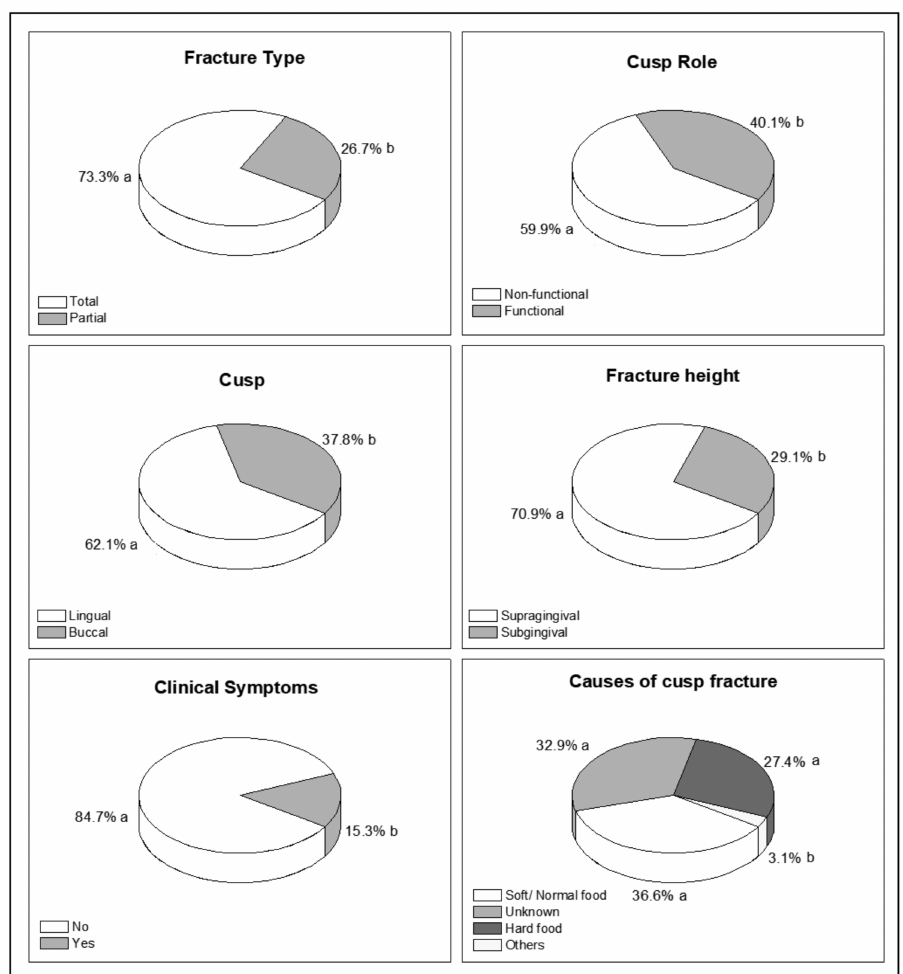
Figure 2. Relative frequency of variables related to teeth characteristics. Groups with the same lowercase letters indicate absence of statistical difference ( α = 0.05; Fisher exact